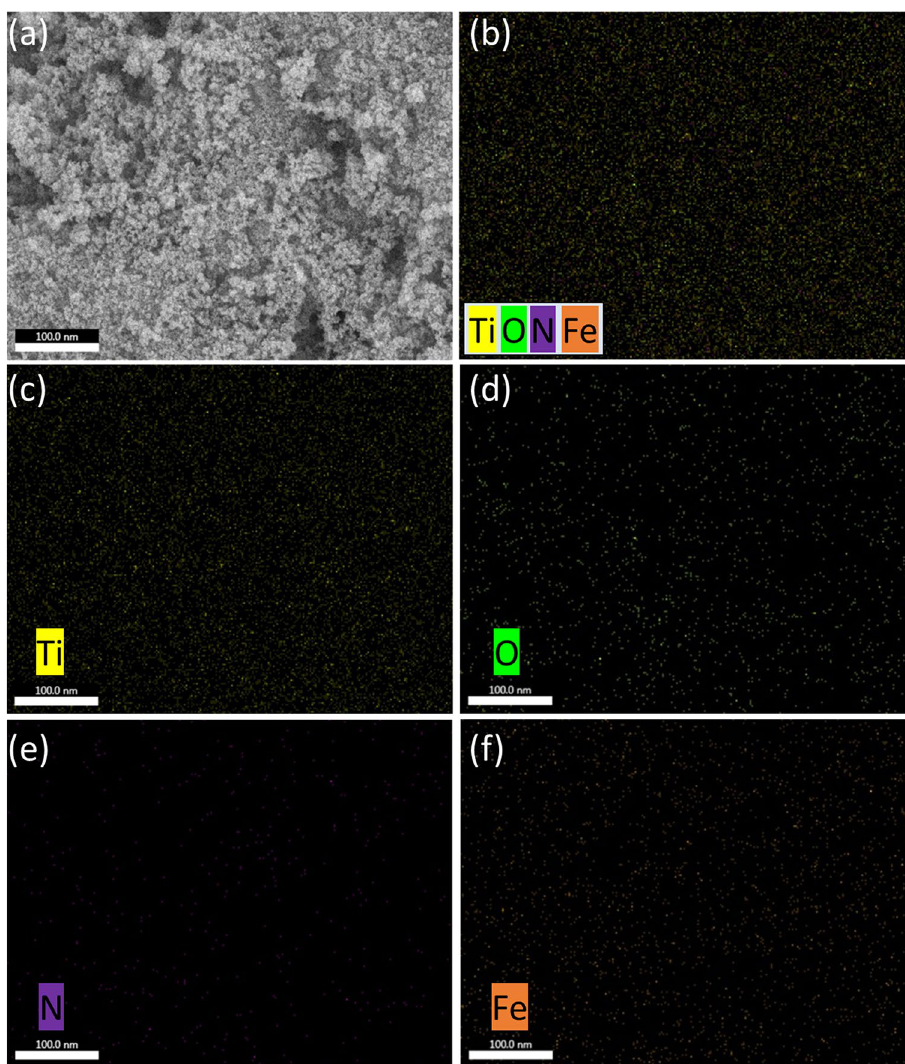
Figure 4. EDX elemental mapping of 4%wt n-TiO 2 @α-Fe 2 O 3 nanocomposite.